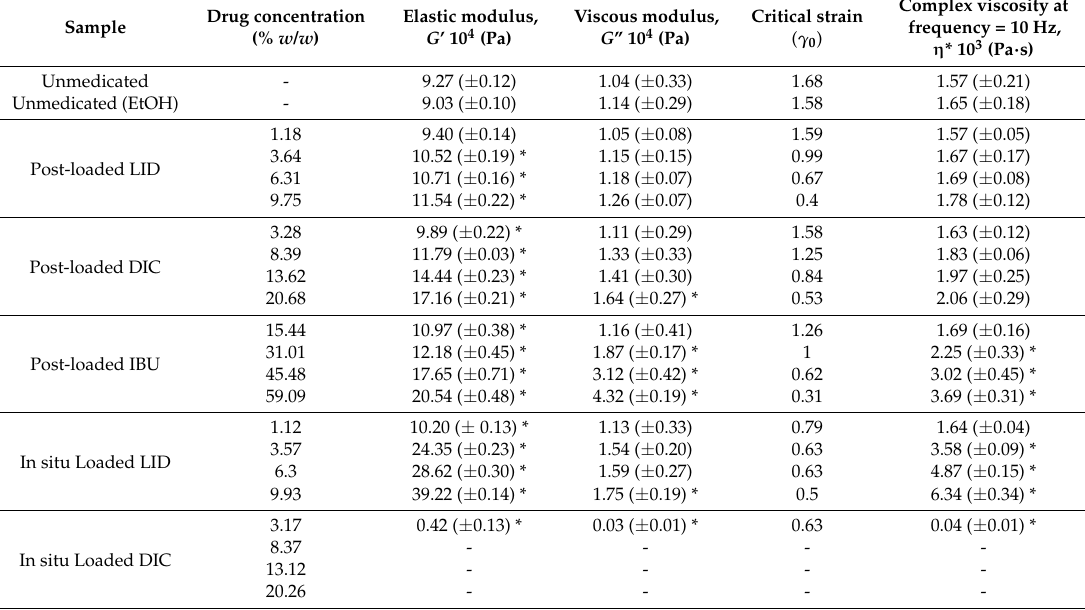
Table 6. Effect of loading method and drug physicochemical properties on the mechanical properties. Values in brackets indicate the standard deviation from reported mean ( n = 3; * Significantly different from corresponding unmedicated hydrogels; p <